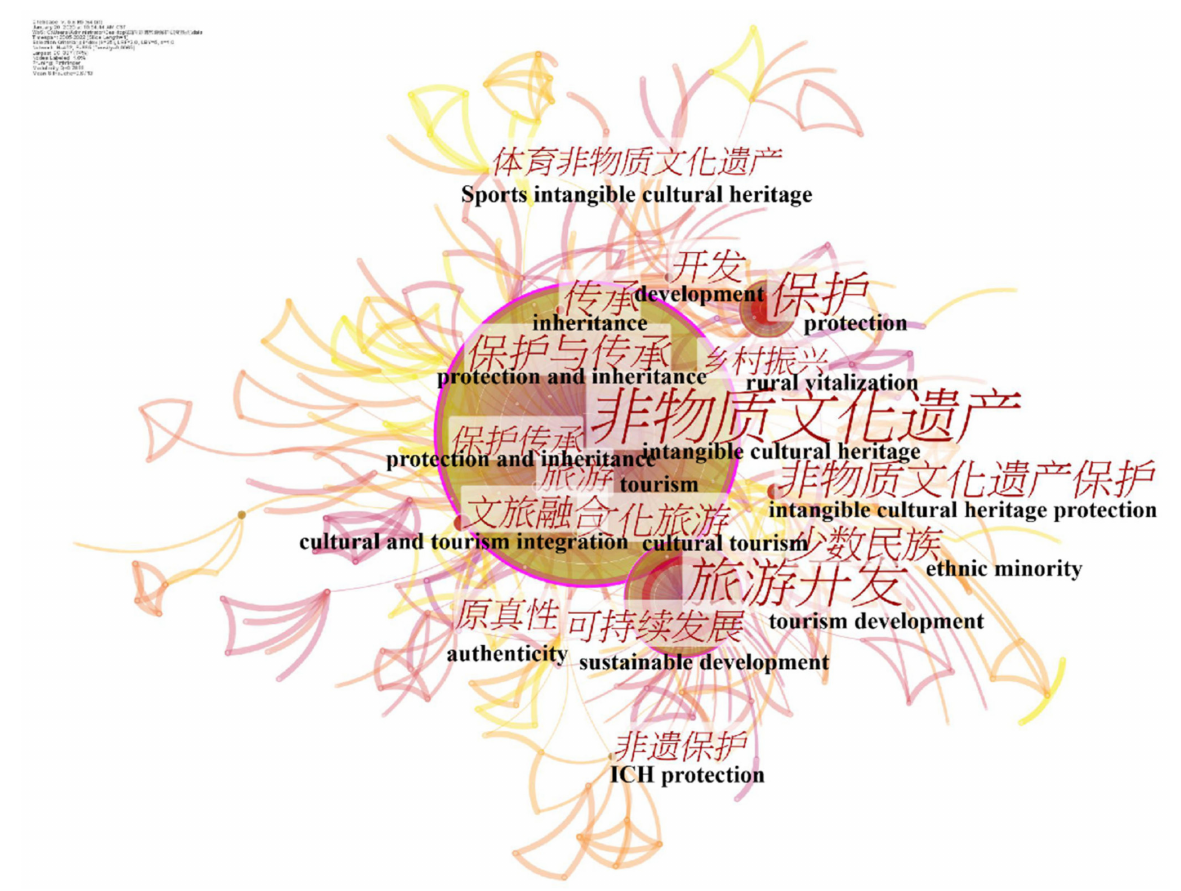
Figure 3. Co-occurrence network of keywords in Chinese journals.